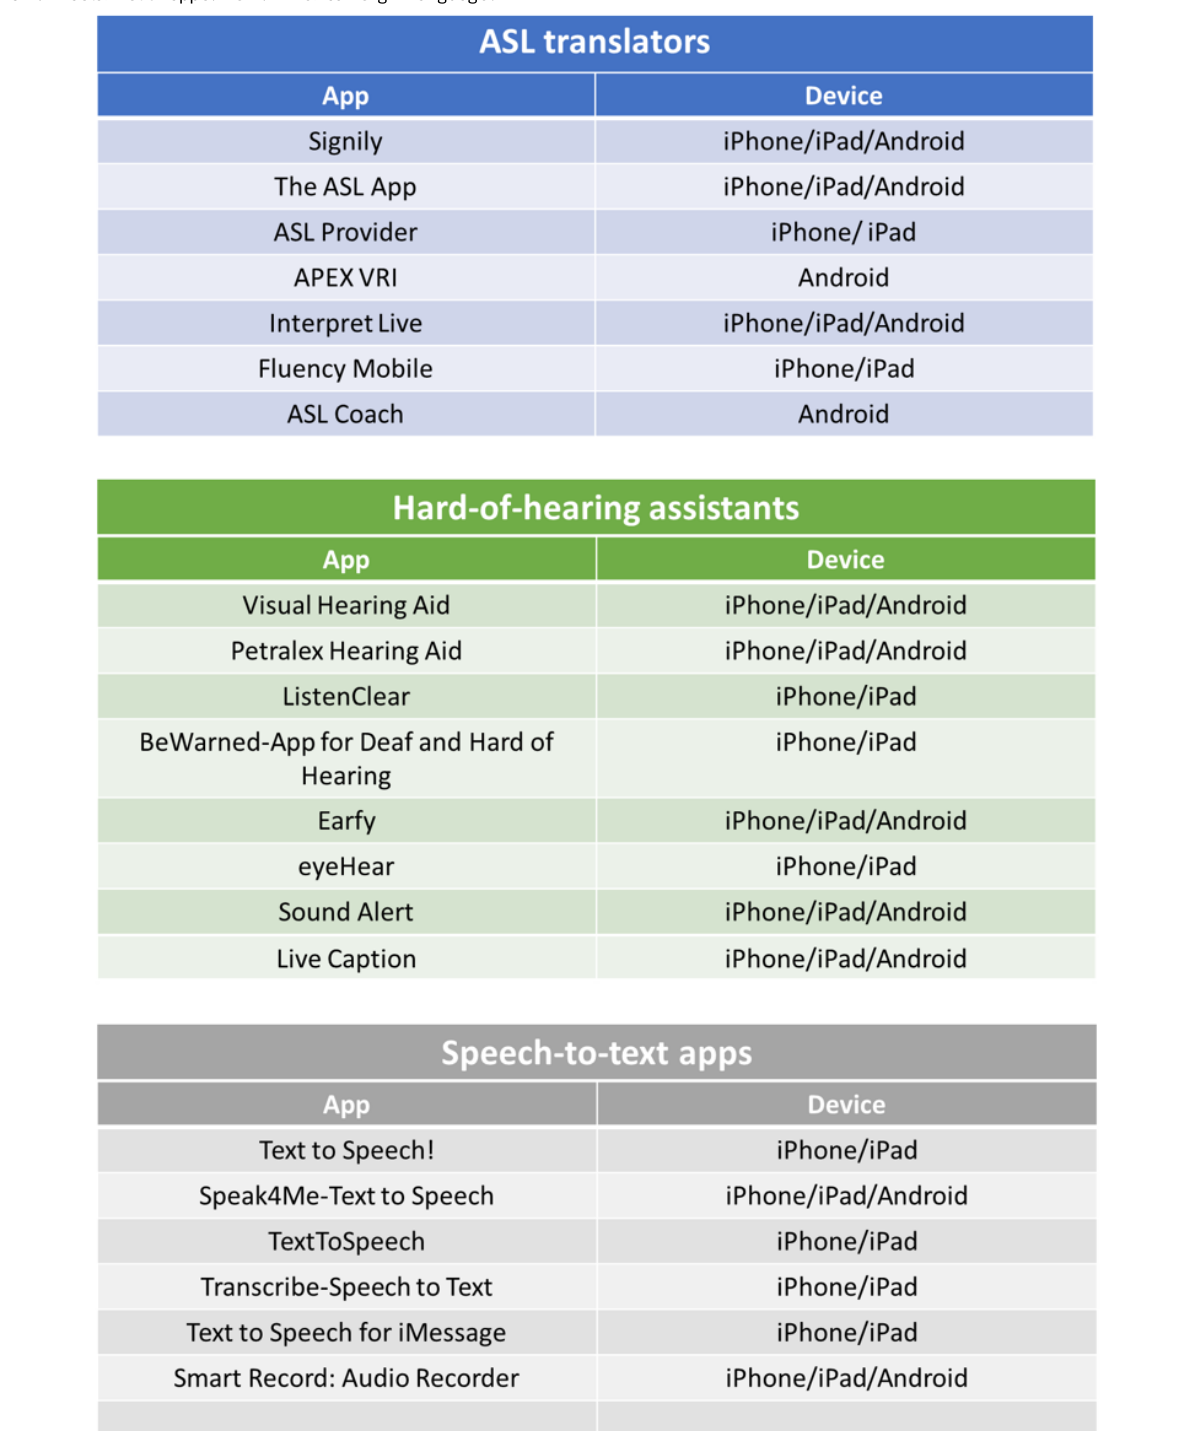
Figure 2. Master list of apps. ASL: American Sign